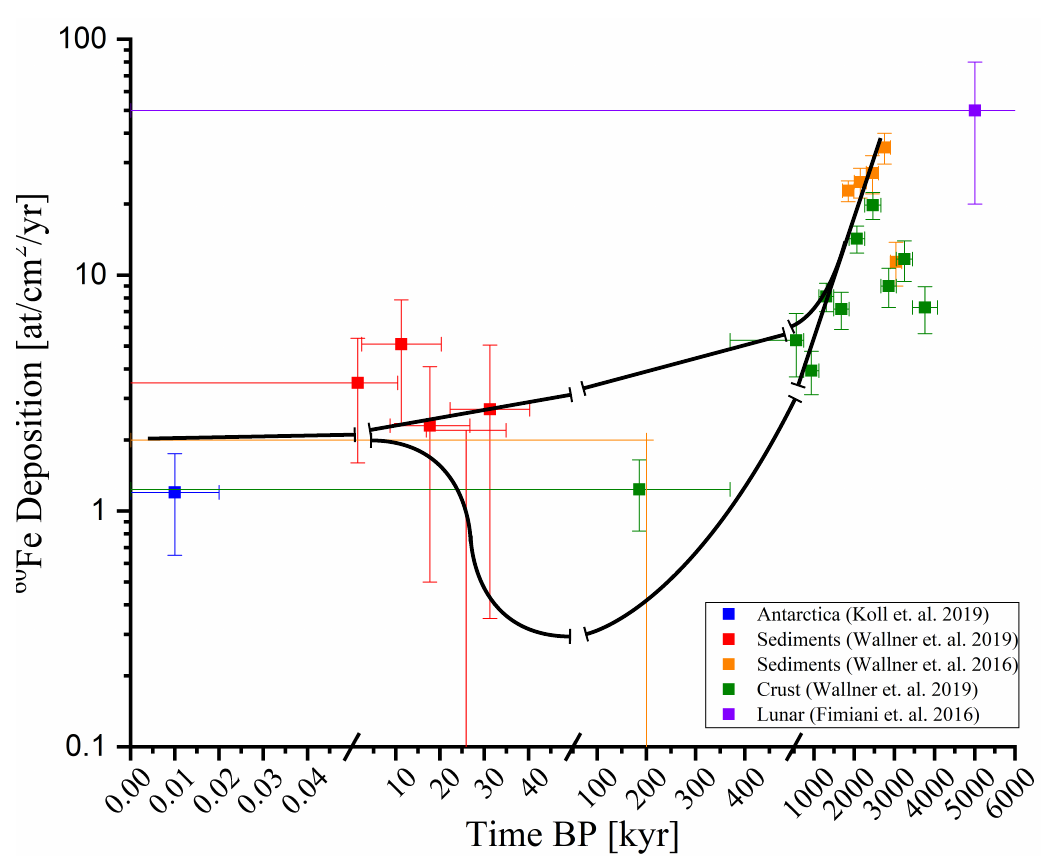
Figure 2: Compilation of 60 Fe investigations over four di ff erent timescales with focus on the recent component of their data. The lunar data only gives an integral value over several Myr, the top layers of the crust and the previous sediments over several 100 kyr. The crust data fits remarkably well with the Antarctic snow data. The top layer of the sediment from [5] only gave an upper limit consistent with most of the recent data within the errors. The black lines indicate possible influx patterns which could be assumed for di ff erent origins of the recent 60